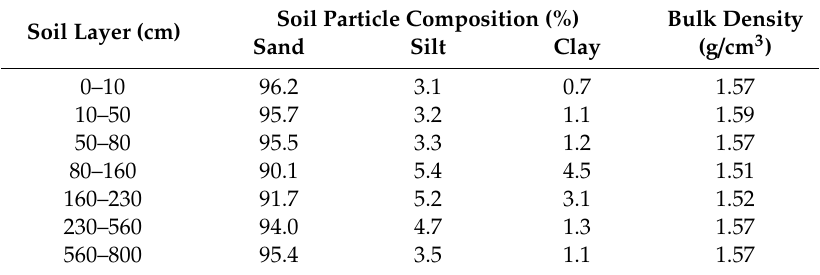
Table 1. Measured soil particle composition and bulk density at di ff erent depths.